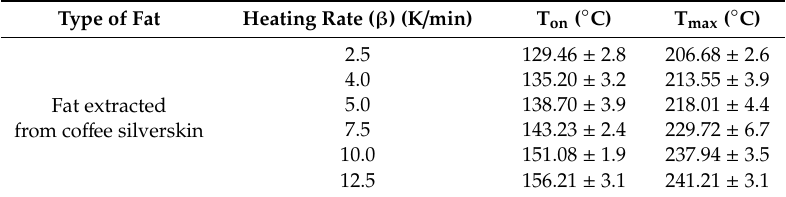
Table 1. T on and T max obtained for di ff erent heating rates in thermo-oxidation process of fat extracted from silverskin.